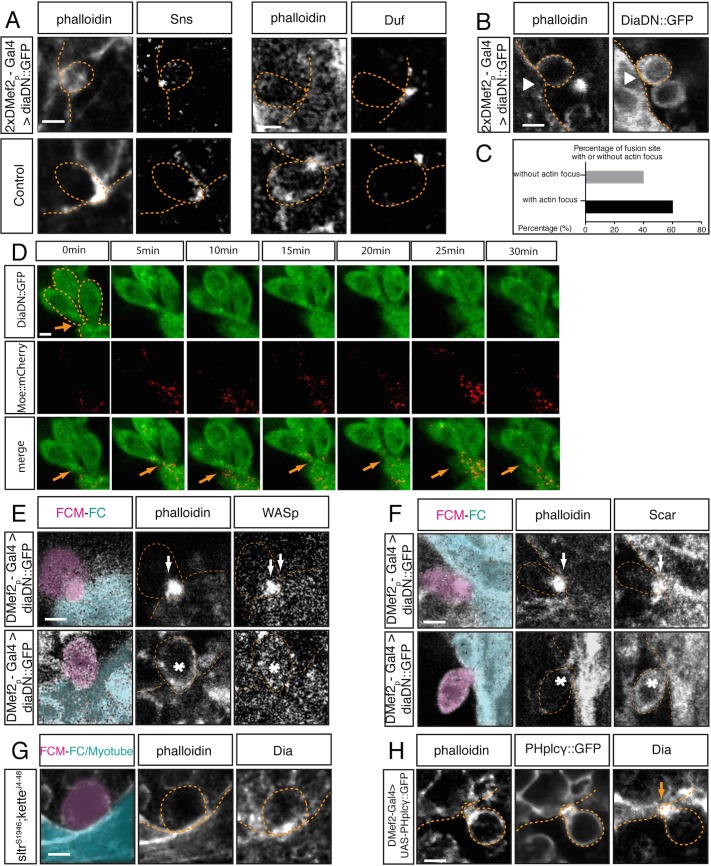
Dia regulates actin and Arp2/3 activity during myoblast fusion.
A. In stage 15 embryos expressing 2xUAS-diaDN::GFP, myoblasts are stained with phalloidin and antibodies against DiaDN::GFP. Immunostaining for Sns and Duf was used to examine cell adhesion. Sns and Duf localize correctly at the fusion site, confirming adhesion between FCMs and FC/myotube. B. Stage 15 embryos expressing 2xUAS-diaDN::GFP with 2xDMef2-Gal4. Myoblasts are stained with phalloidin and antibodies against GFP. Arrowhead points to a myoblast adhering to the myotube but failing to generate a F-actin focus. C. Percentage of fusion sites with and without actin focus. Embryos expressing 2x UAS-diaDN::GFP were stained with phalloidin, and the formation of actin focus was quantified in these embryos. Actin focus forms in 60% of fusion sites and is absent in 40%. D. Time-lapse imaging of DiaDN fusion block. Three copies of UAS-diaDN::GFP and one copy of UAS-moesin::mCherry were driven by two copies of Dmef2-Gal4. F-actin dynamics were visualized by moesin::mCherry. Still images from the time-lapse sequence show 2–3 myoblasts adhered to a myotube (dashed lines), but unable to fuse. No F-actin focus was detected at the fusion site (arrow) (S1 Movie; S3I Fig). E-F. Comparison of SCAR and WASp localization in DiaDN-expressing FCMs. In embryos expressing high levels of DiaDN, immunostaining was used to examine the localization of SCAR and WASp. At a fusion site in which an actin focus forms (upper panels), SCAR and WASp both correctly localize to the actin focus (arrow; phalloidin). When actin focus formation is disrupted by DiaDN (lower panels), SCAR and WASp no longer accumulate at the fusion site (asterisk). G. Dia localization in sltr
s1946
; kette
J4-48 double mutant. In this double mutant, phalloidin was used to label F-actin, and Dia antibody to detect the localization of Dia. Fusion is blocked in double mutants, with no actin focus forming. Dia still accumulates at the fusion site. H. Dia localization in myoblasts expressing UAS-PH
plcγ::GFP. Stage 15 embryos expressing 2xPH
plcγ::GFP with 2xDMef2-Gal4. Myoblasts are labeled with antibodies against GFP. PH
plcγ sequesters PI(4,5)P2, generating a small actin focus and blocking myoblast fusion[54]. In an FCM that adheres to a FC, immunostaining reveals that Dia accumulates at the fusion site. Scale bar: 2.5μM.